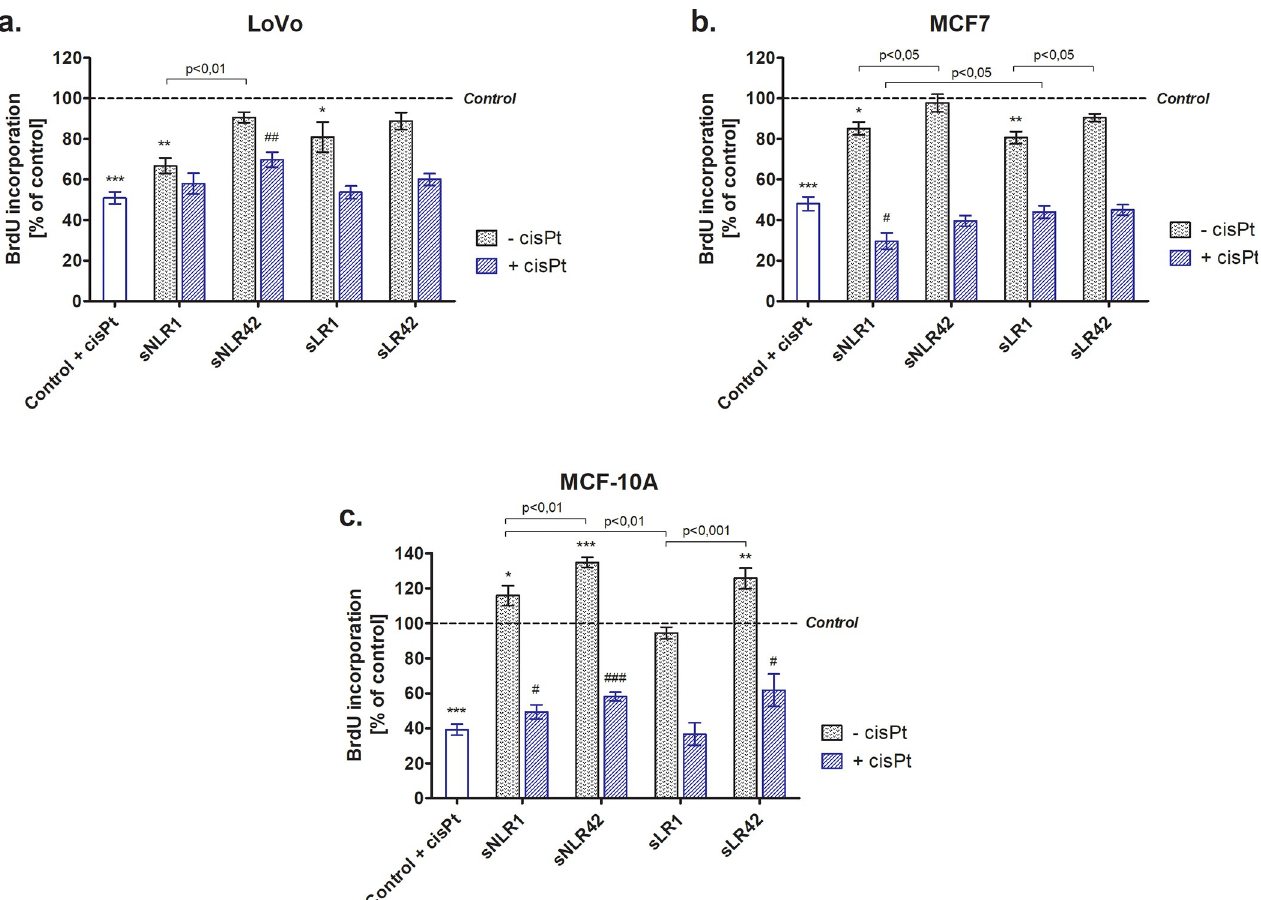
Fig 2. Proliferation of LoVo (panel a), MCF7 (panel b), and MCF-10A (panel c) cells, assessed by the BrdU incorporation during DNA synthesis, after incubation (24 h) with the PRBC supernatants (5%) in the absence or presence of cisPt (panel a and b: 25 μ M; panel c: 40 μ M). All data is presented as a percentage of control (untreated cells—assumed as 100%). Error bars denote ± SD, n = 15 (3 independent experiments, each performed with supernatants of PRBCs derived from five donors); � /# p < 0.05; �� /## p < 0.01; ��� /### p < 0.001 vs. compared to the appropriate control.